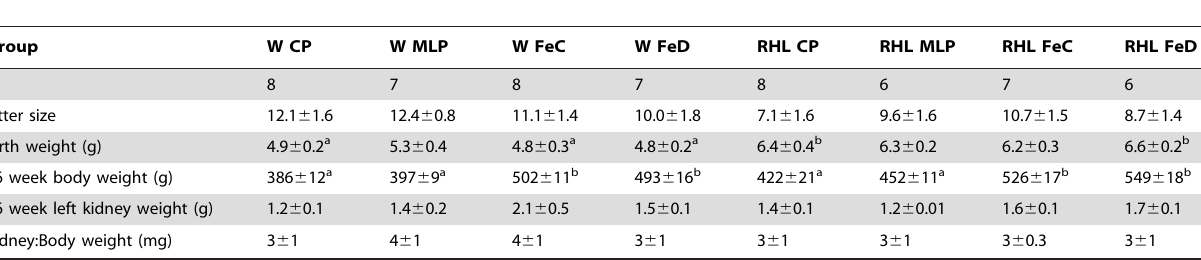
Table 1. Male birth weight, 16 week body weight, 16 week left kidney weight, and kidney:body weight ratio.